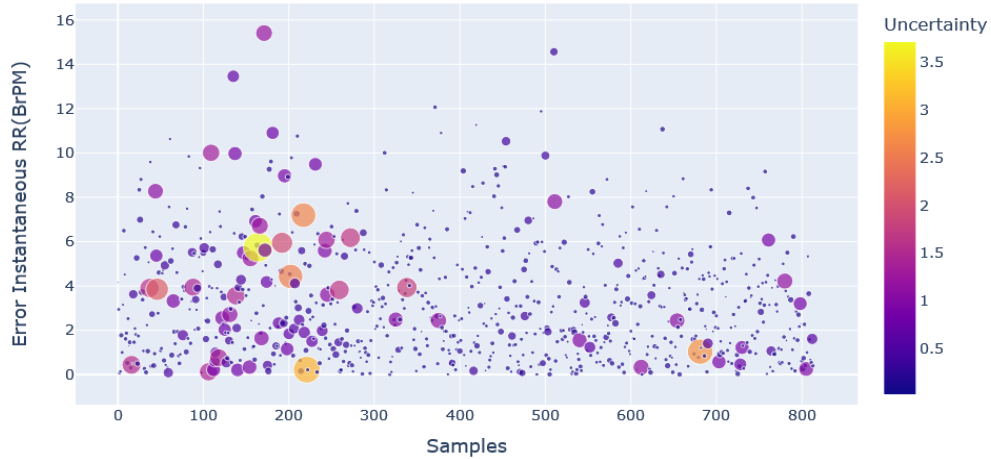
Figure 8. Scatter plot of uncertainty distribution with respect to error in instantaneous RR prediction.